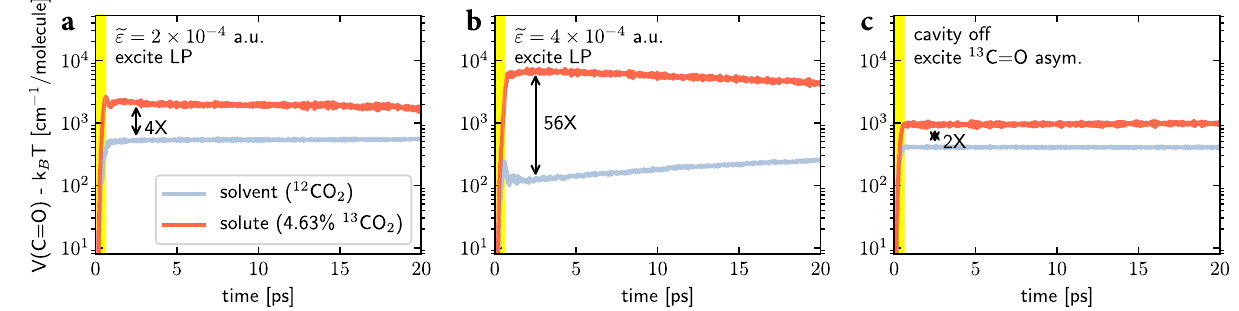
Fig. 3 Time-resolved dynamics for the average C = O bond potential energy per molecule. Three conditions are compared: ( a ) e ε ¼ 2 ´ 10 (cid:2) 4 a.u. after exciting the LP at 2241 cm − 1 (the same as Fig. 2d); ( b ) e ε ¼ 4 ´ 10 (cid:2) 4 a.u. after exciting the LP at 2177 cm − 1 (the same as Fig. 2h); and ( c ) outside the cavity after exciting the 13 C = O asymmetric stretch at 2262 cm − 1 . In each subplot, the 12 CO 2 solvent is drawn with a gray line and the 4.63% 13 CO 2 solute is drawn with a red line. The y -axis is plotted in a logarithmic scale, and the yellow region denotes the time window (0.1 < t < 0.6 ps) during which the external pulse is applied. Note that although the nonequilibrium local IR spectrum in Fig. 2 was calculated using a single trajectory, 40 trajectories are averaged here to obtain an ensemble-averaged result; see Supplementary Methods for simulation details.